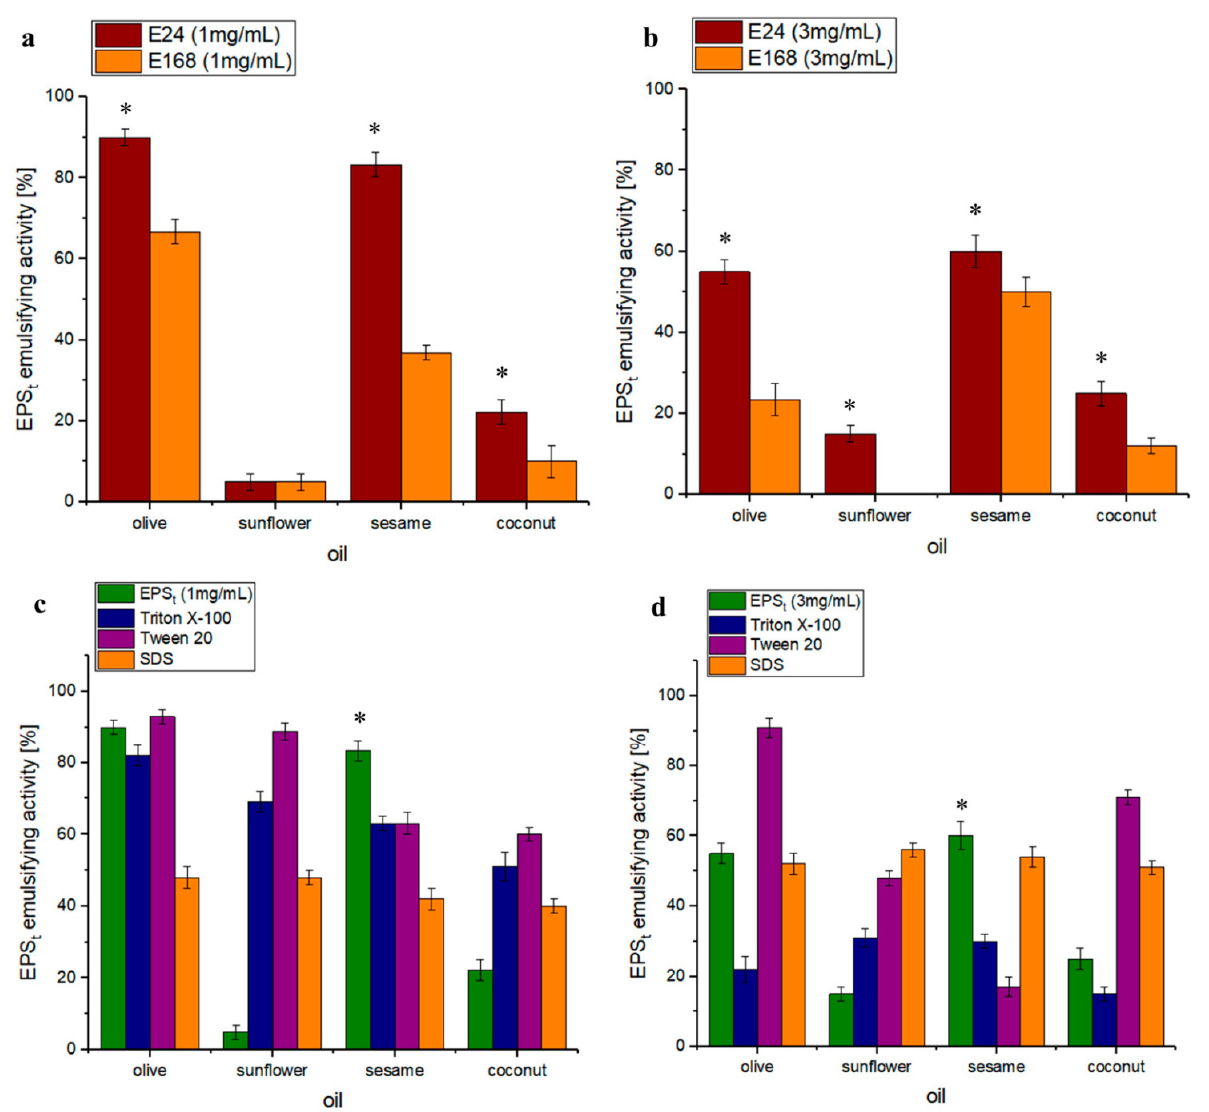
Figure 8. ( a ) Emulsifying properties with 1 mg/mL of EPS t . The percentage of emulsion of EPS t with the different oils used at 24 h (E24) and 168 h (E168) of study. ( b ) Emulsifying properties with 3 mg/mL of EPS t . The percentage of emulsion of EPS t with the different oils used at 24 h and 168 h of study. ( c ) Comparison of the emulsifying properties with 1 mg/mL of EPS t against commercial emulsifiers (Triton X − 100, Tween 20 and SDS) across different natural oils. ( d ) Comparison of the emulsifying properties with 3 mg/mL of EPS t against commercial emulsifiers (Triton X − 100, Tween 20 and SDS) across different natural oils. (n = 3, significant differences * p < 0.05).